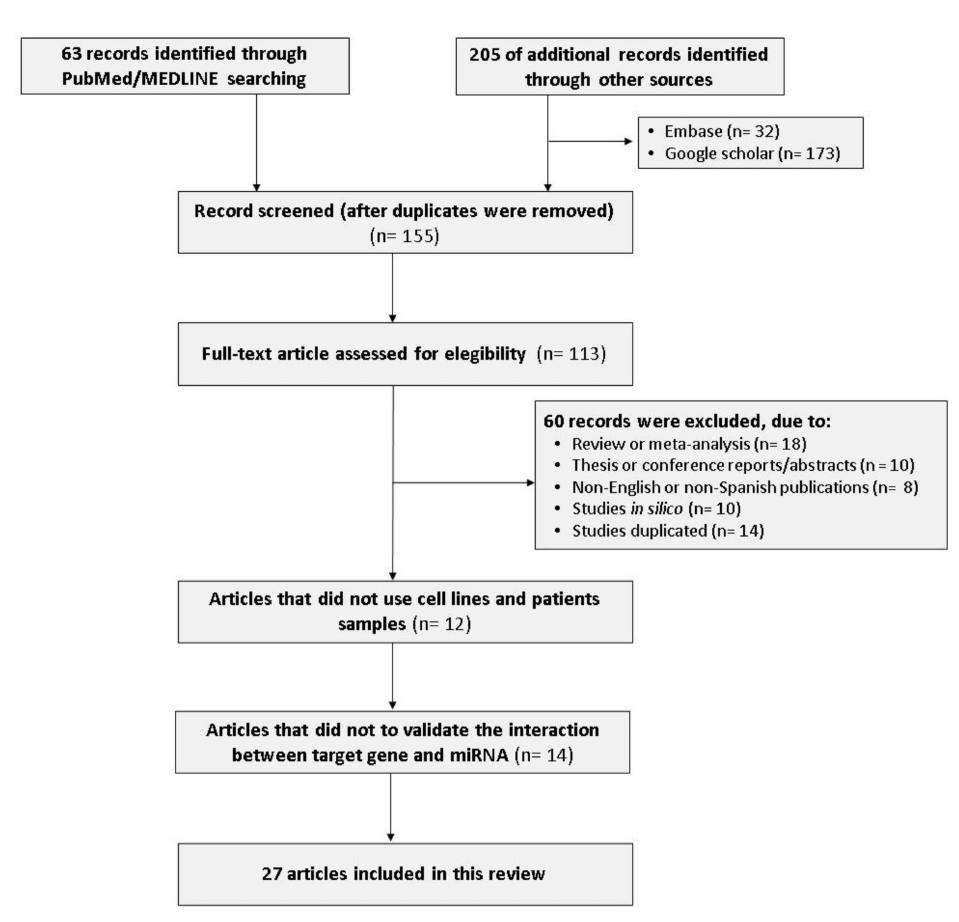
Figure 3. The flow chart of data identification and